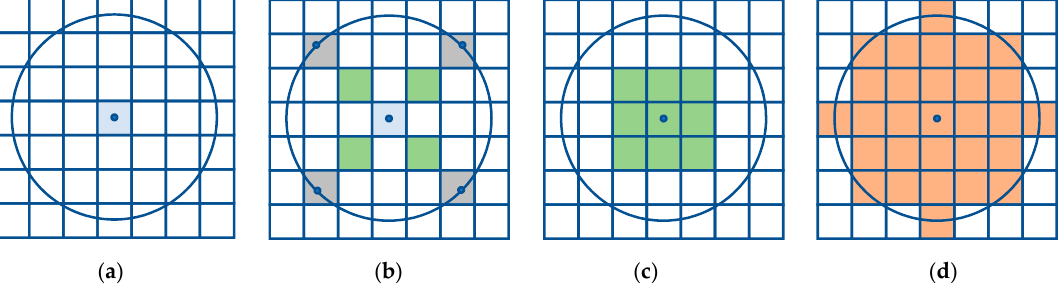
Figure 4. ( a ) A point, its quantized cell (shown in light blue), and a rectangular grid of cells that bound the offset region. ( b ) Each of the four grey cells has a vertex neighbor (shown in green) closer to the light blue cell that is fully contained in the offset region. ( c ) A rectangular grid of cells that are fully contained in the offset region (shown in green). ( d ) The cells that represent the offset region (shown in orange).